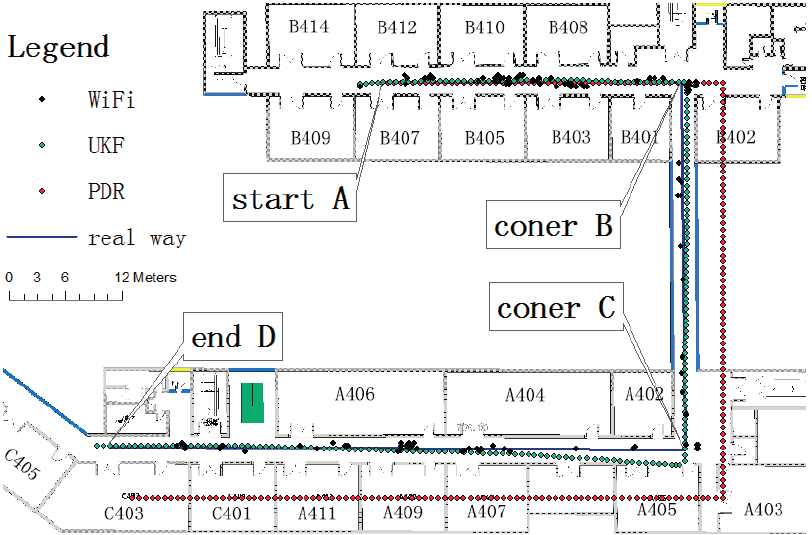
Figure 13. UKF positioning